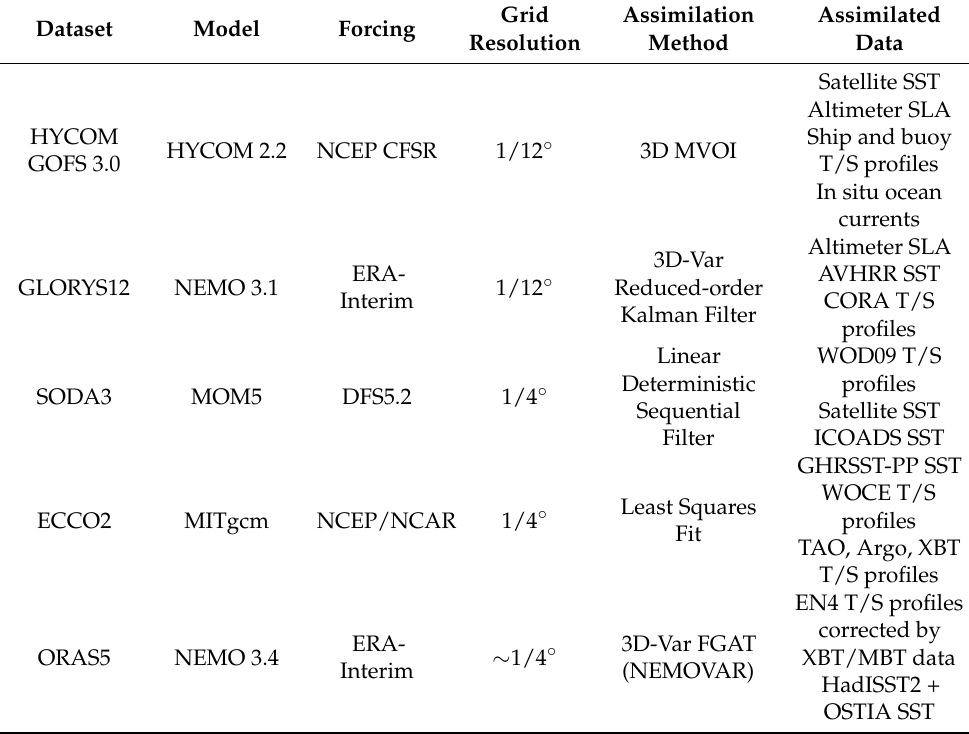
Table 1. List of ocean reanalysis